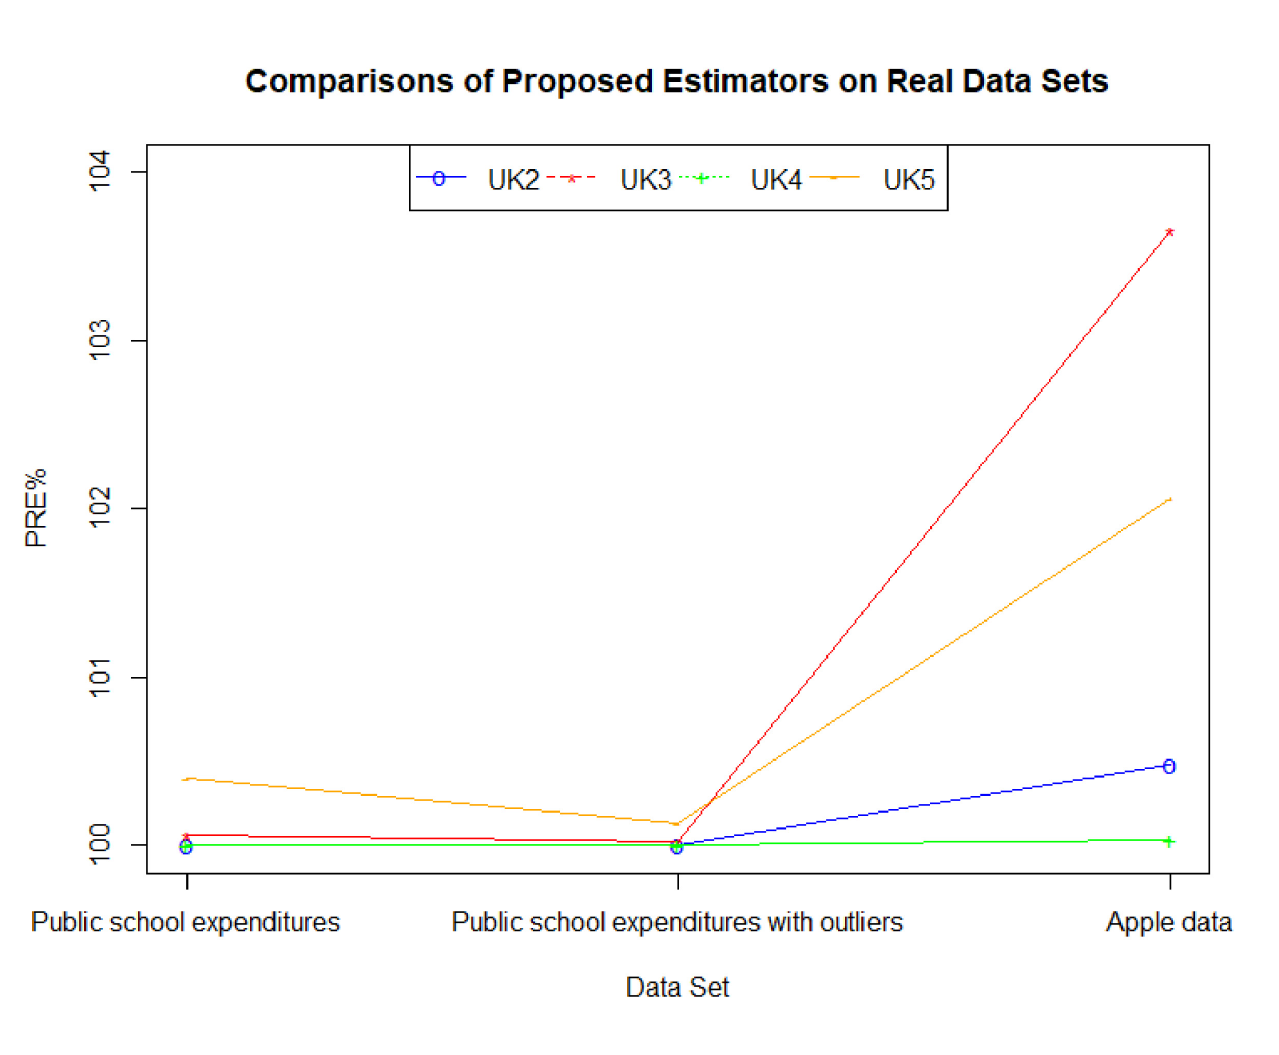
Fig 4. Comparison plot of the proposed